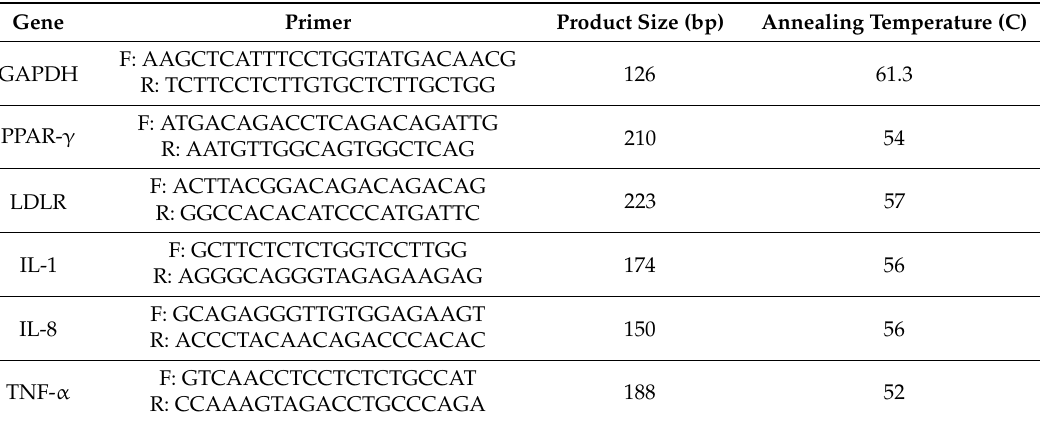
Table 1. Specific primers used for real-time quantitative